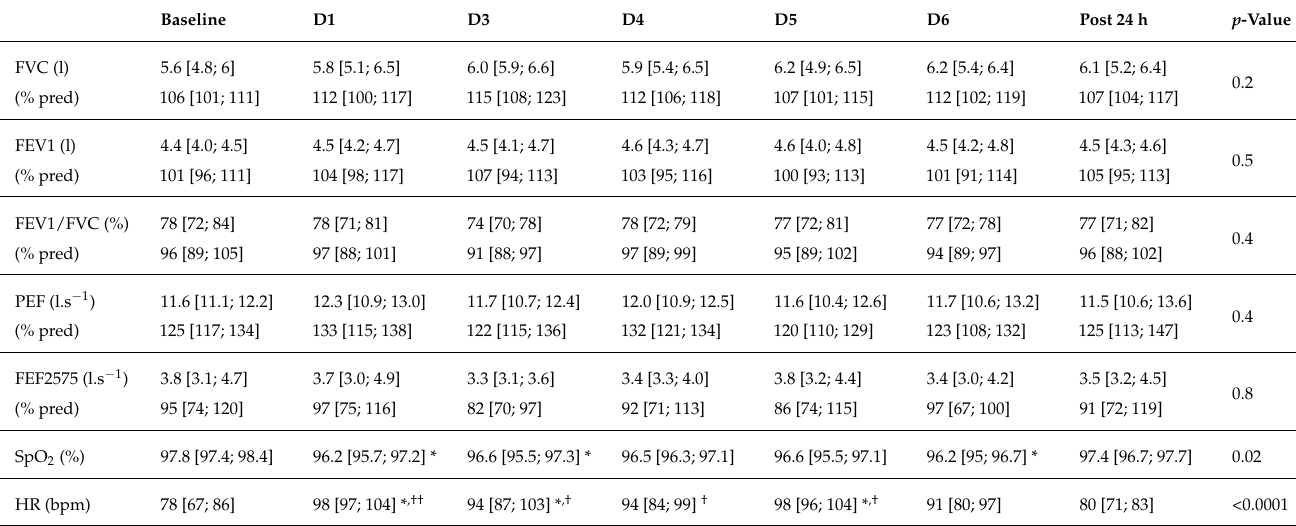
Table 3. Spirometry parameters. Data were assessed at baseline and 150–180 min after each day dive. FCV, forced vital capacity; FEV1, forced expiratory volume in one second; PEF, peak expiratory flow; FEF2575, forced expiratory flow; SpO 2 , pulse oxygen saturation; HR, heart rate. Data are expressed in absolute value and the percentage of expected values according to the GLI (% pred). p -value for the ANOVA. Tukey’s multiple comparisons test is expressed versus baseline with * p < 0.05. Differences versus post-24 h are expressed with † p < 0.05 and †† p <